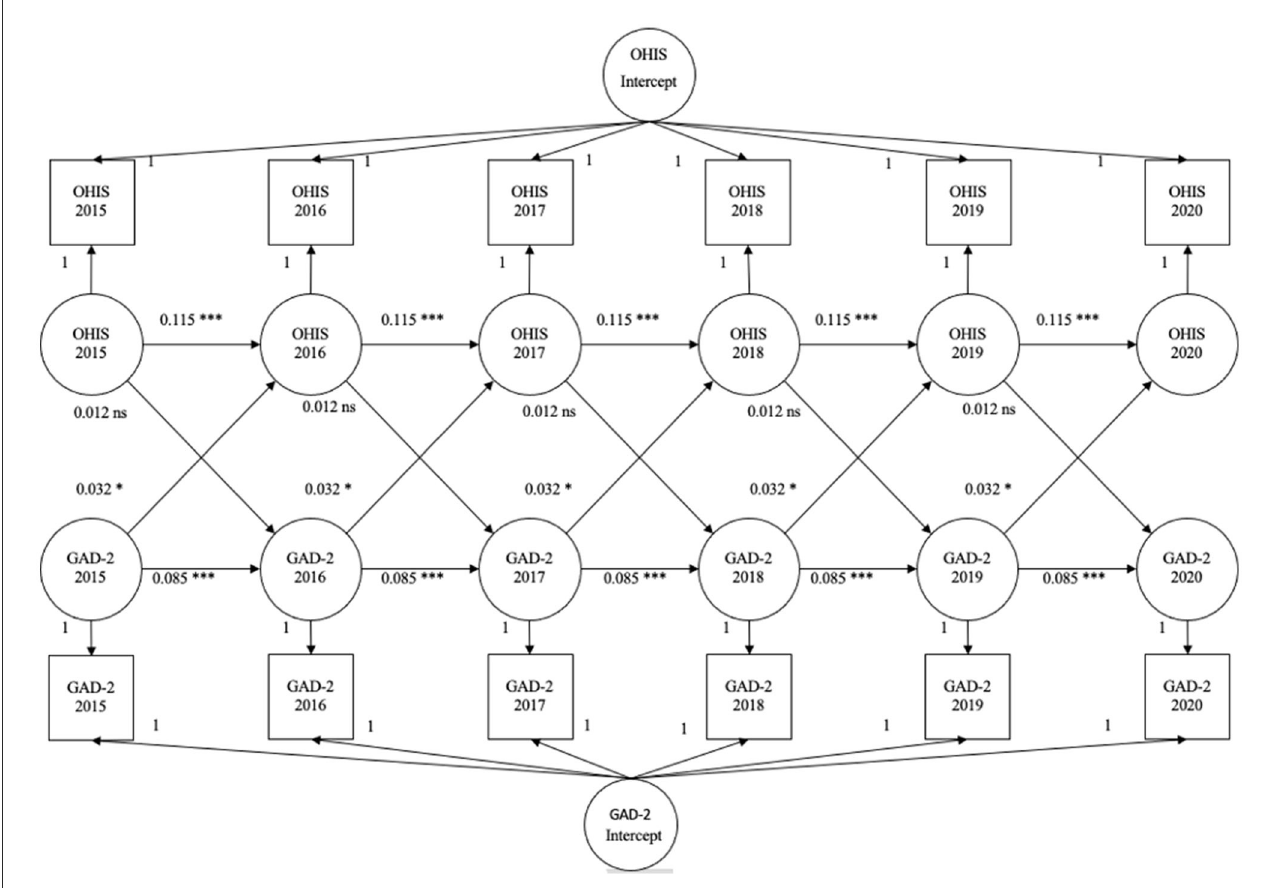
FIGURE1 Results of RI-CLPM. * p < 0.05, *** p < 0.001, ns = not